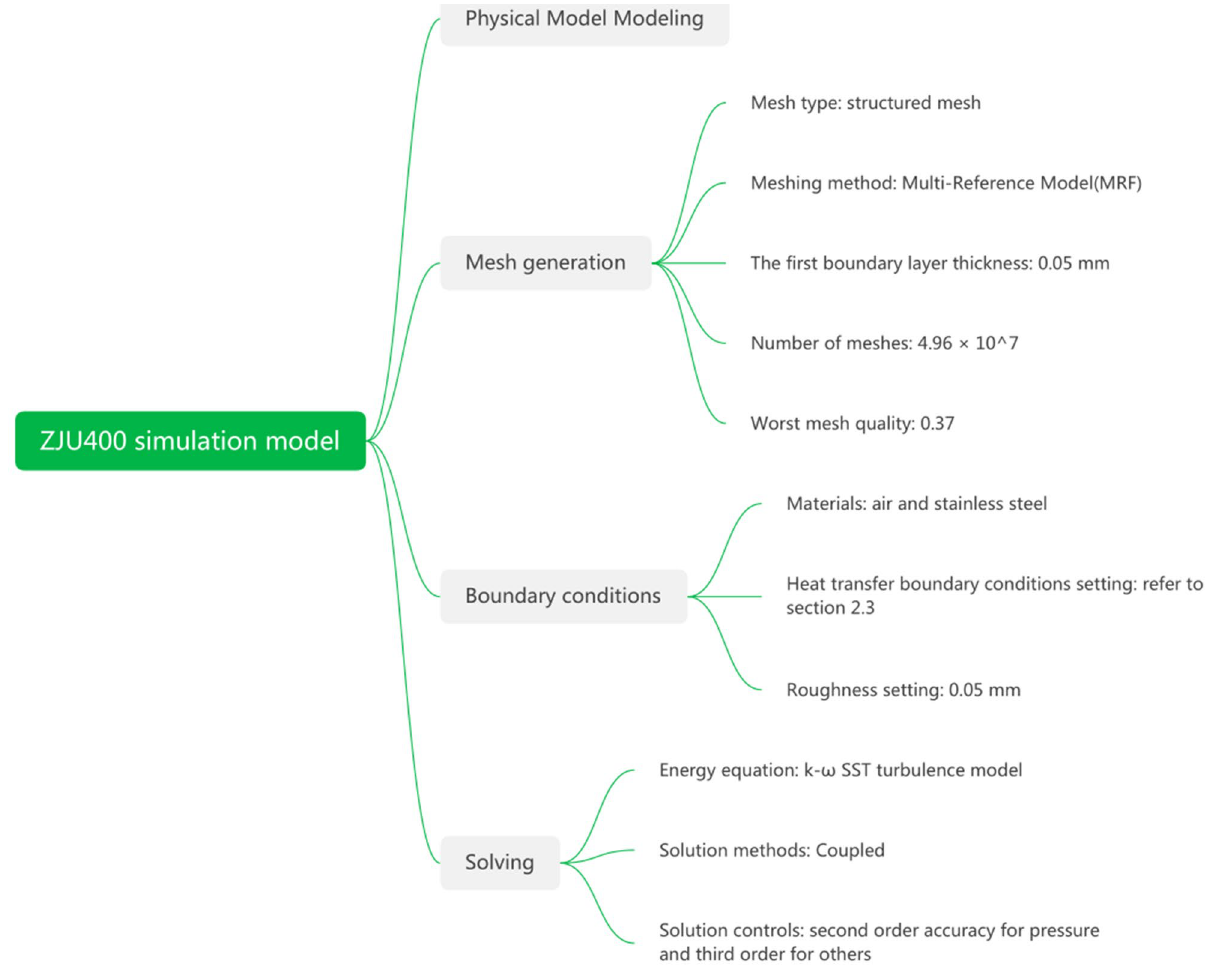
Fig. 4 Flow chart of